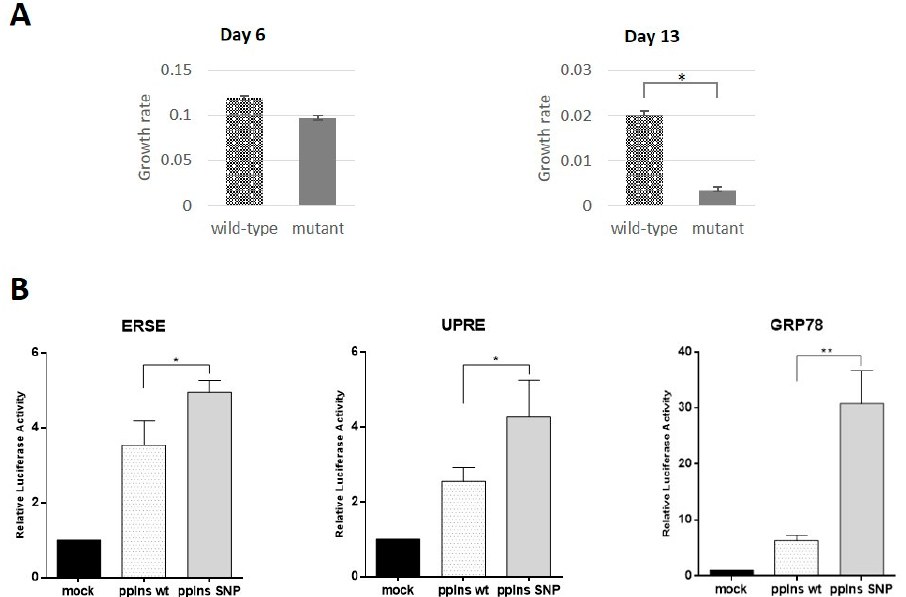
Figure 5. The INS splice isoform inhibits growth rate and activates endoplasmic reticulum stress response in MIN6 insulinoma cells. ( A ) Proliferation rate of MIN6 cells transfected with the mutant and wild type INS cDNA sequences at days 6 and 13 after transfection. ( B ) Activation of luciferase gene under control of ER stress response element (ERSE) (left panel), unfolded protein response element (UPRE) (middle panel) or GRP78/BiP promoter (right panel) in MIN6 cells in the presence of phCMV-preproIns wild type and SNP are shown. The data are presented as means ± SD ( n = 3), * p < 0.05, ** p < 0.01. All results are normalized to the activity of β -galactosidase.